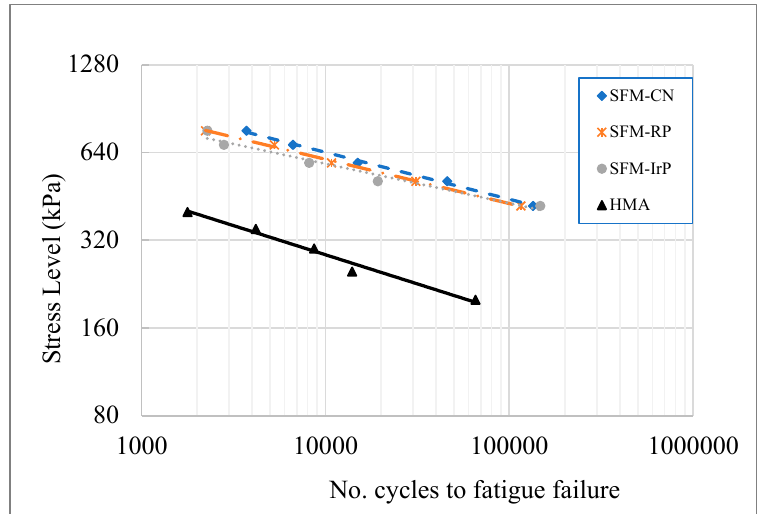
Figure 8. Fatigue life at different stress ratios.